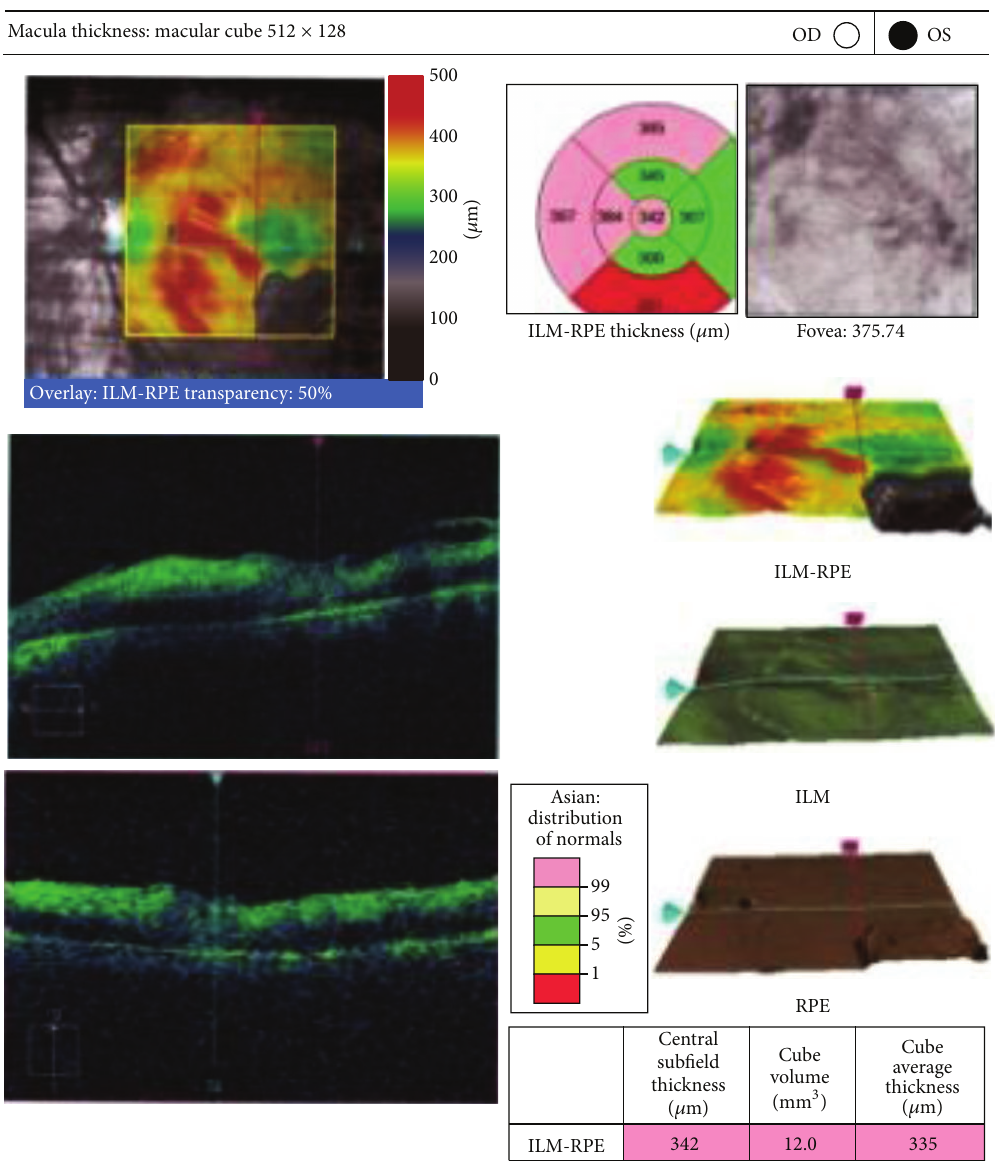
Figure 7: OCT showing increased macular thickness.